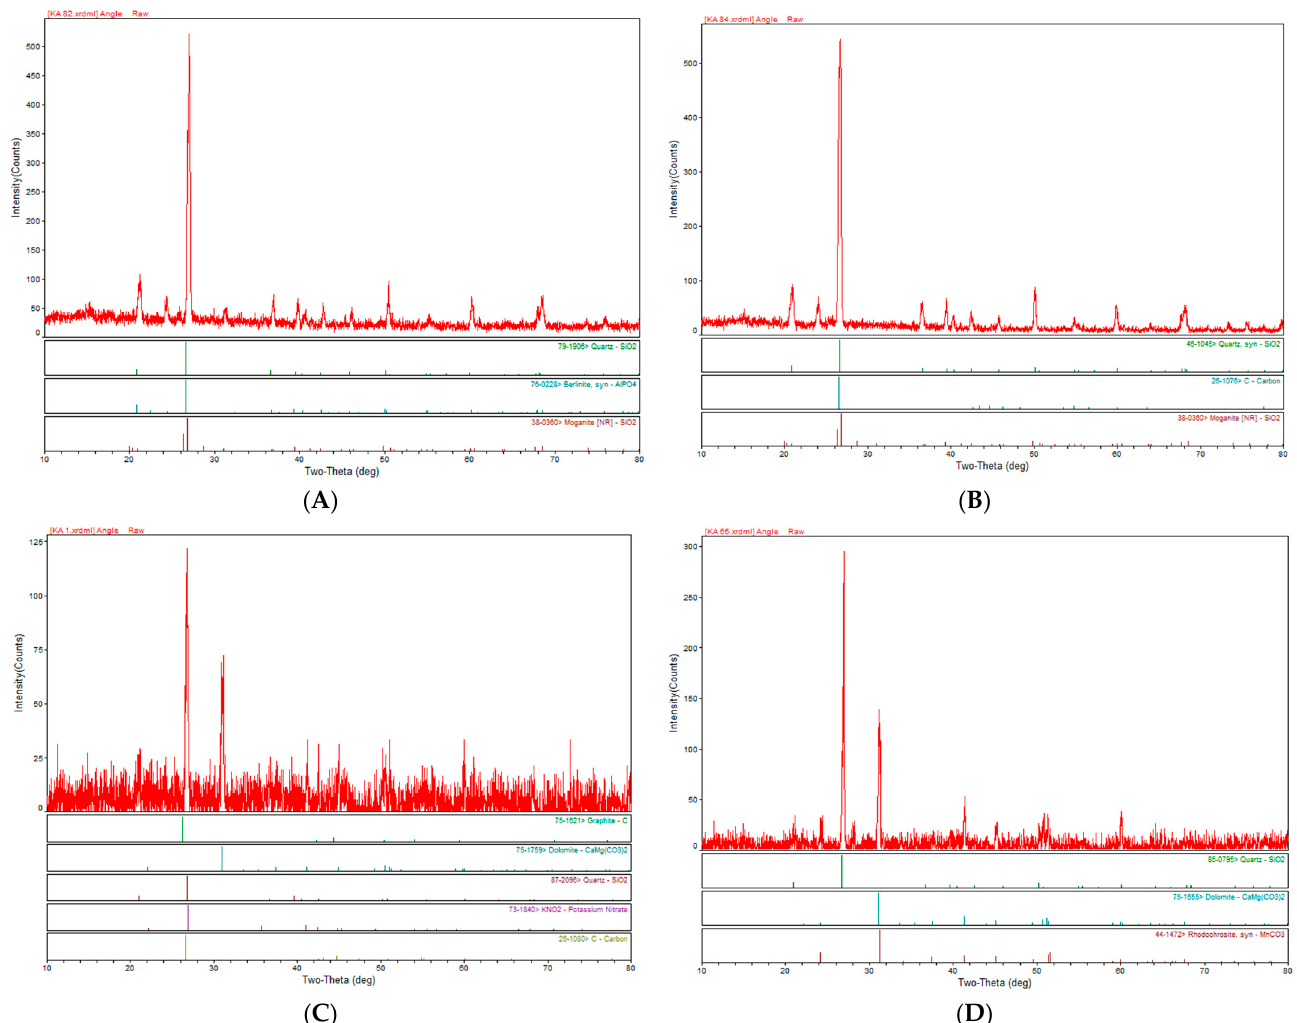
Figure 10. XRD pattern of the Abbottabad Formation. ( A ) Fine crystalline dolomite (LA-1; Dol. I; sample no. KA-1); ( B ) dolomite (LA-3; Dol. IV; sample no. KA-65); ( C ) quartzite (LA-4; arenite microfacies; sample no. KA-82); ( D ) dolomite (LA-1; Dol. II; sample no. KA-84).